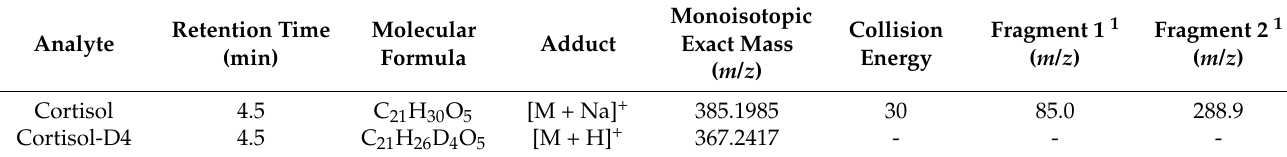
Table 1. UHPLC-Q-Orbitrap parameters of cortisol and